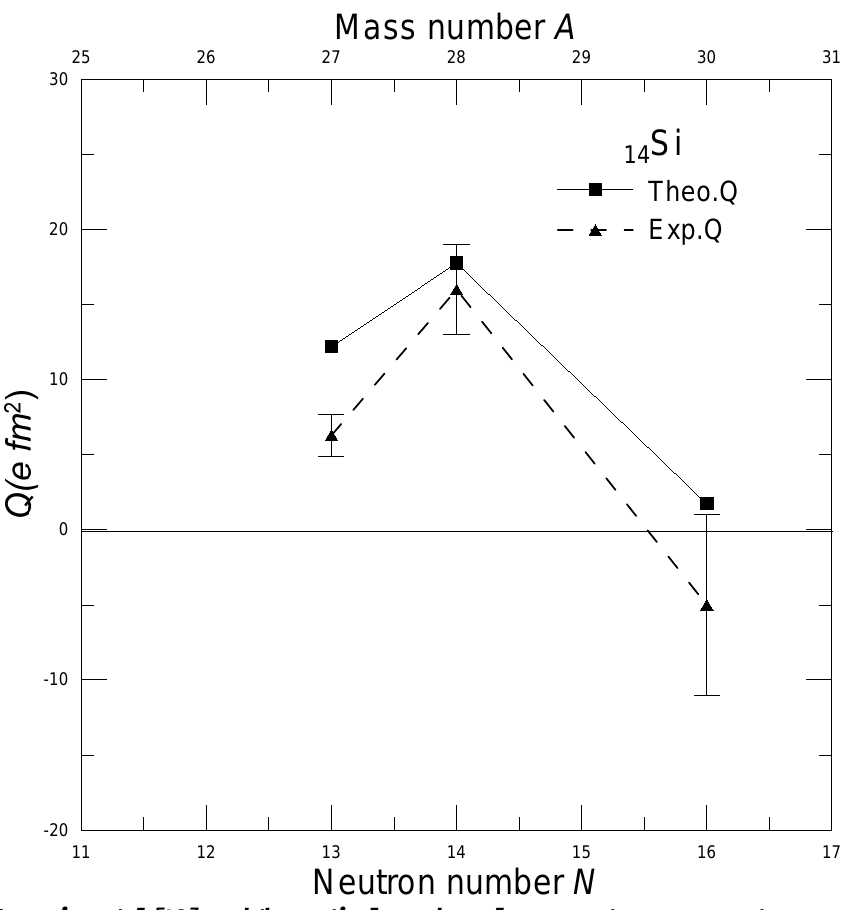
Fig. 2: Experimental [18] and theoretical quadrupole moments versus neutron number for Si isotopes.